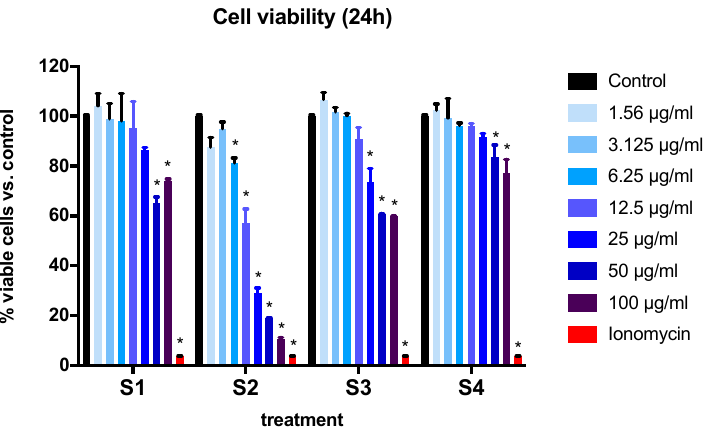
Figure 3. BEAS-2B cell viability expressed as percentage of viable cells after exposure to four di ff erent soot preparations for 24 h. The graph summarizes data from three independent experiments ( n = 3 replicates per experiment), with results normalized to control cells (exposed to DMSO). Data are expressed as mean ± SEM. * p < 0.001 (Dunnett’s post hoc multiple comparisons test). Two-way ANOVA interaction: p < 0.0001, F (21, 36) = 11.59; concentration e ff ect: p < 0.0001, F (7, 36) = 100.4; soot type e ff ect ( p < 0.0001, F (3, 36) = 127.6). For a description of S1–S4, see Section